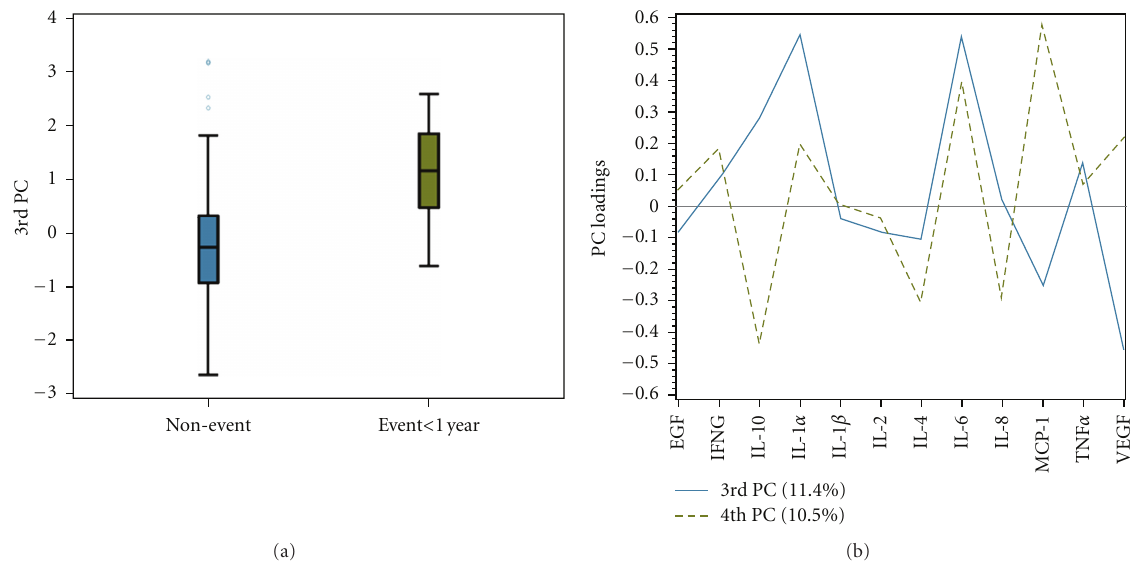
Figure 2: Dimension reduction using principal component analysis: the third PC was found to be the most associated with outcome. (a) The distribution of the 3rd PC is displayed separately by outcome. Filled areas indicate the interquartile range (distance between 25th and 75th percentiles), the middle line corresponds to the median, and the whiskers contain data within 1.5 interquartile ranges. (b) The PC loadings for the 3rd and 4th PCs are displayed. The 3rd PC is heavily loaded by positive IL-1 α and IL-6 and negative VEGF values, whereas the 4th PC is heavily weighted by positive IL-6 and MCP-1 and negative IL-10 values.